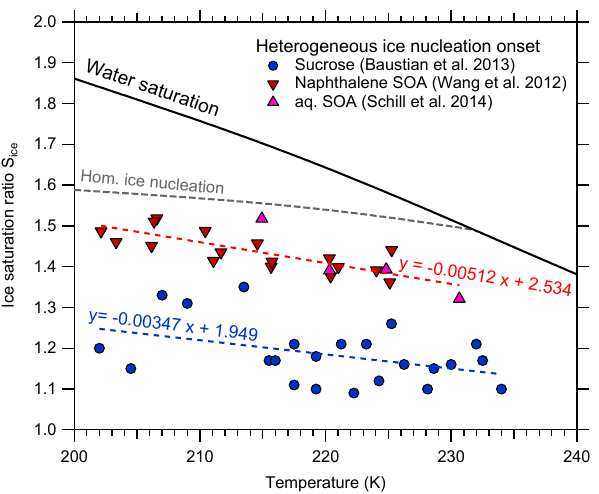
Figure A1. Determination of heterogeneous ice nucleation onsets. For sucrose, data from Baustian et al. (2013) (blue circles) are fit- ted. For SOA, deposition freezing data on naphthalene SOA from Wang et al. (2012) (red downward triangles) as well as nucleation data on aqSOA from Schill et al. (2014) (pink upward triangles) are used. The resulting linear regression fits (blue and red dashed lines) lie significantly below the homogeneous nucleation limit and are displayed along with their parameterizations.